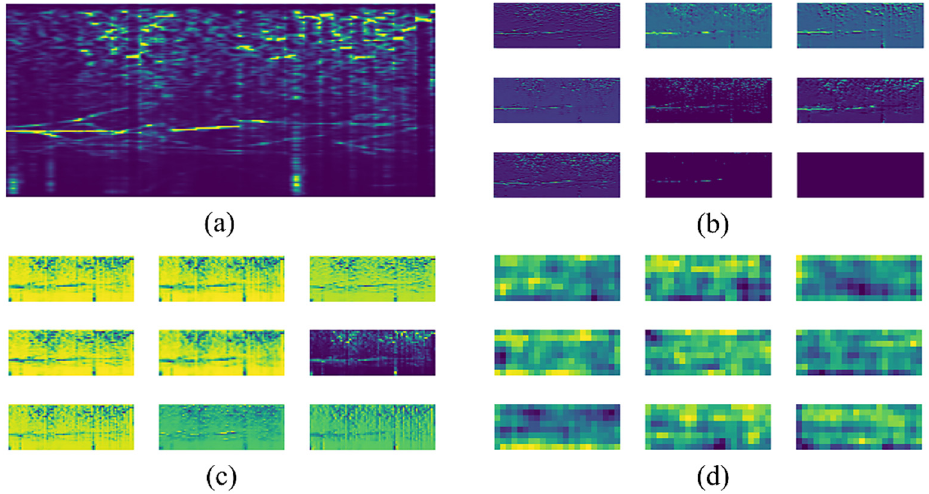
Figure 2. Visualization results on receptive fields of different convolution layers. ( a ) The spectrogram feature of the input, ( b ) the receptive field at layer 6, ( c ) the receptive field at layer 12, and ( d ) the receptive field at layer 48.